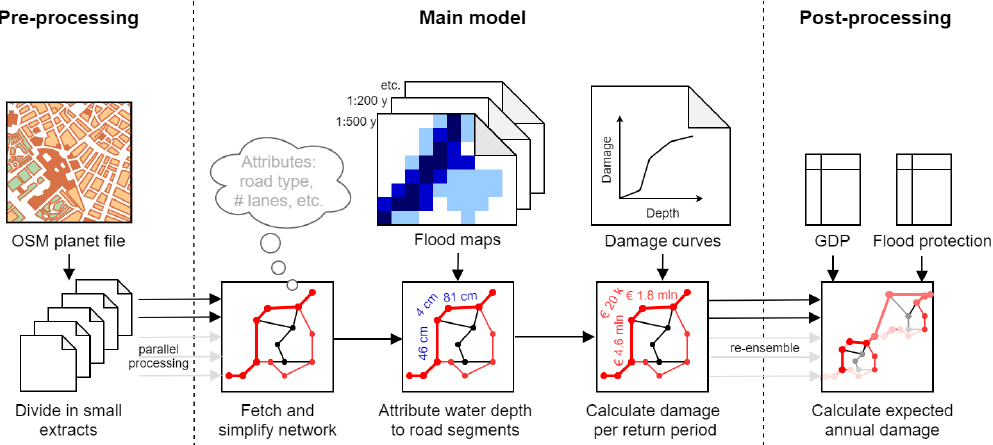
Figure 2. Stylized overview of the object-based